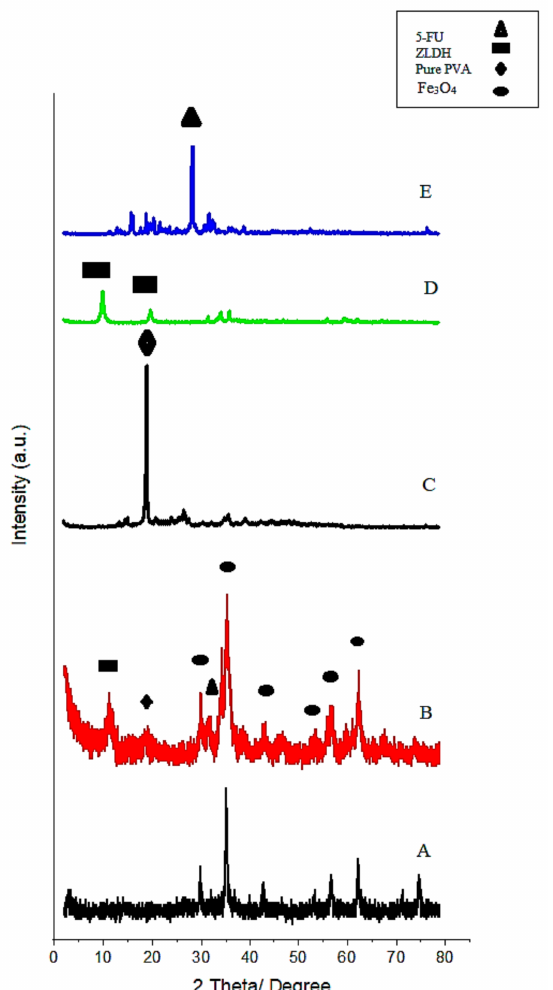
Figure 1. X-ray powder diffraction patterns of the pure Fe 3 O 4 nanoparticles ( A ) and FPVAFU-ZLDH ( B ), polyvinyl alcohol (PVA) ( C ), ZLDH ( D ), and 5-fluorouracil (5-FU) ( E